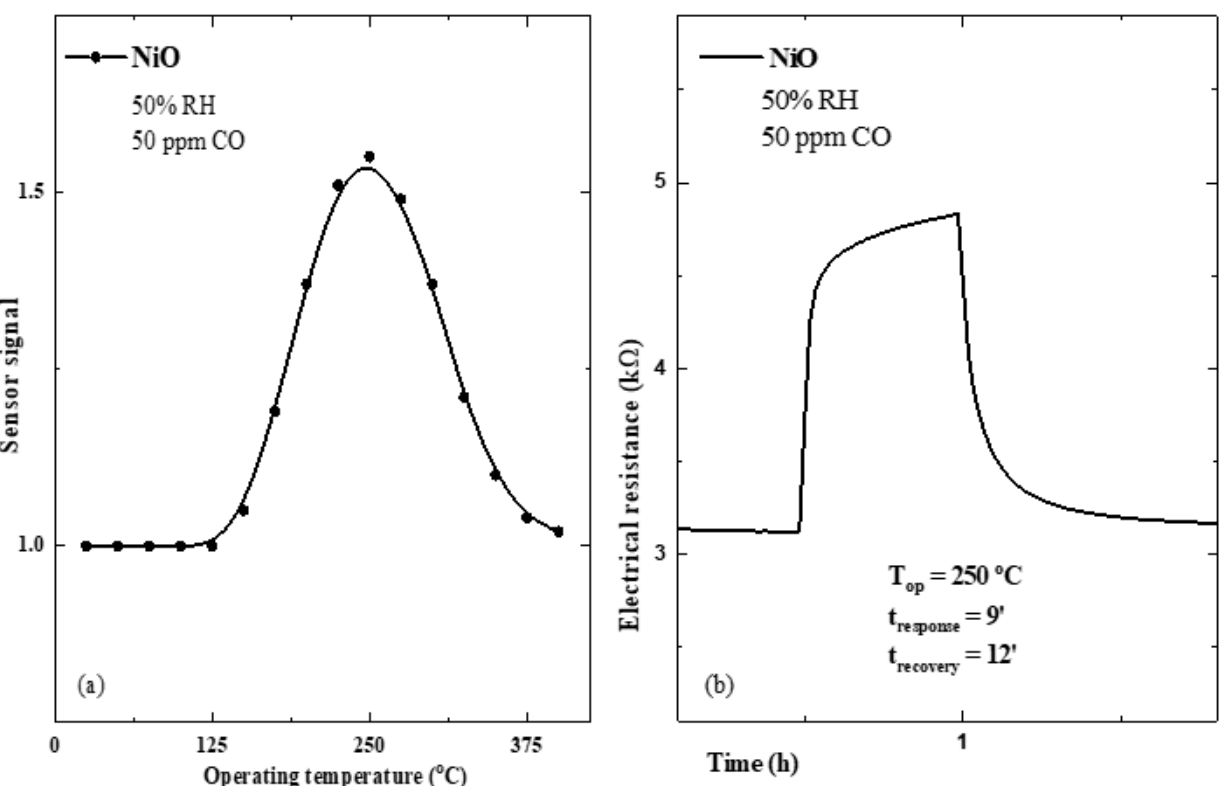
Figure 4. Sensor signal for NiO toward 50 ppm CO under 50% RH with respect to the operating temperature ( a ) and transients ( b ).